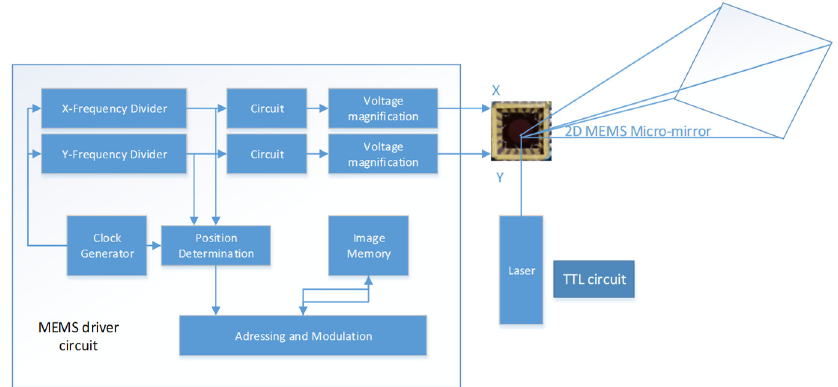
Figure 10. Block diagram of hardware overall design. Table 1. Initialization parameter of the scanning projection system.